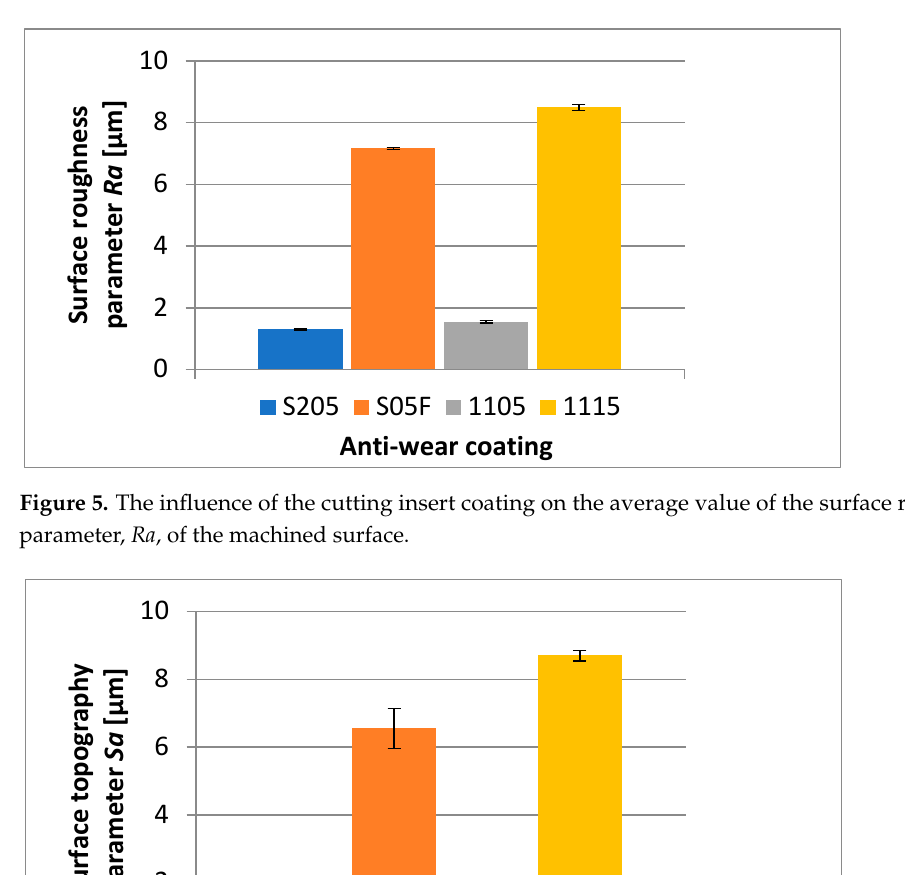
Figure 5. The influence of the cutting insert coating on the average value of the surface roughness parameter, Ra , of the machined surface.